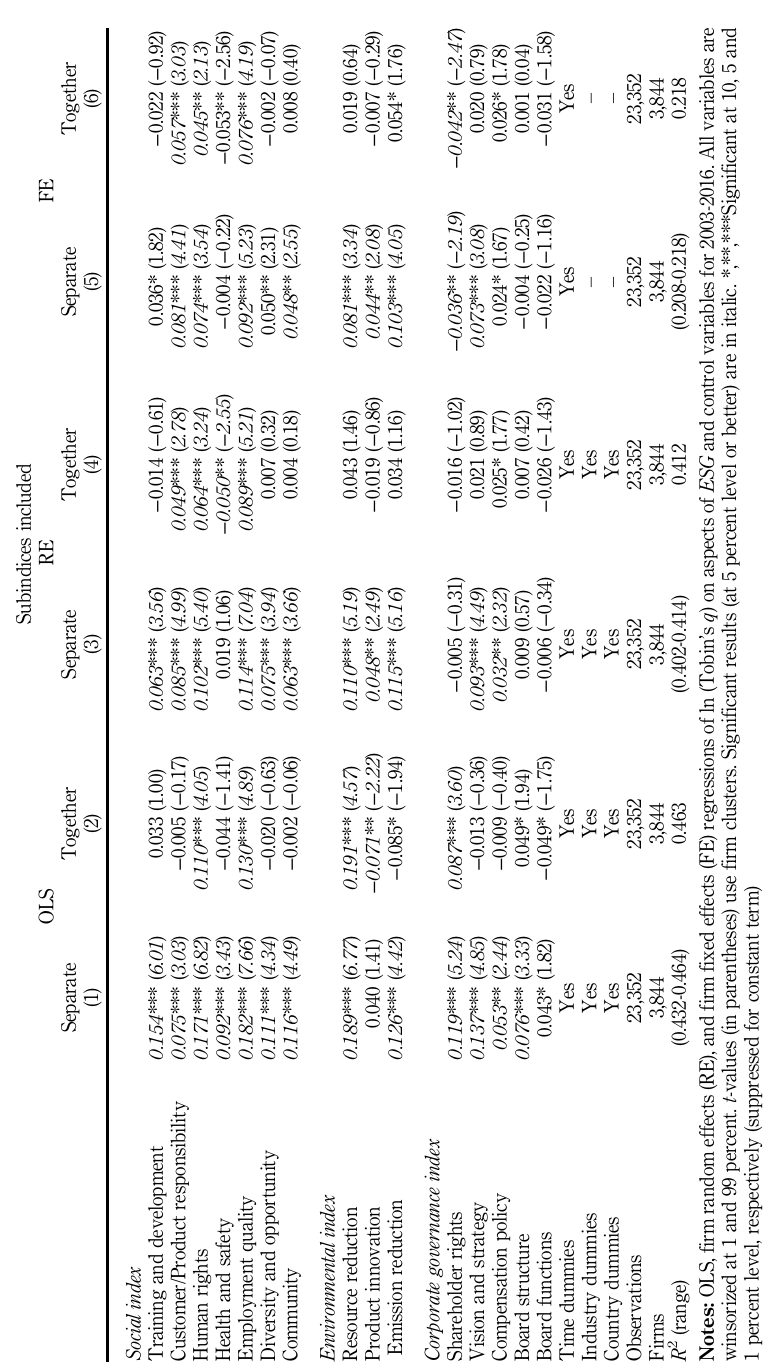
Table VI. Aspects of